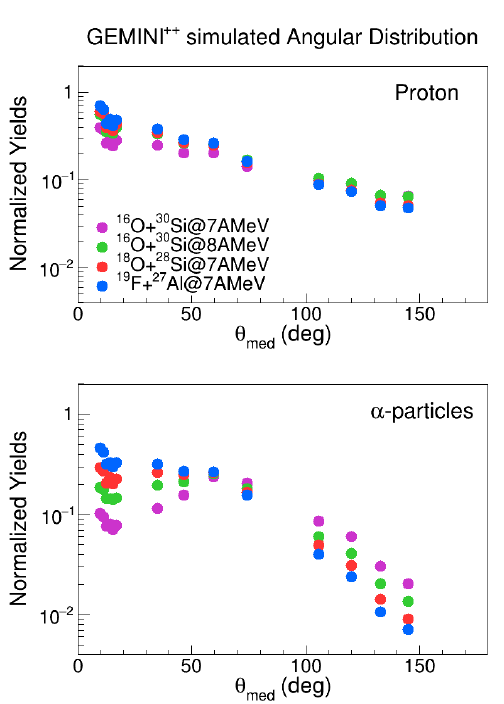
Fig. 3. Ratio of experimental and simulated proton (upper panel) and  -particles (lower panel) yields as a function of the detection angle of the particles for the four studied